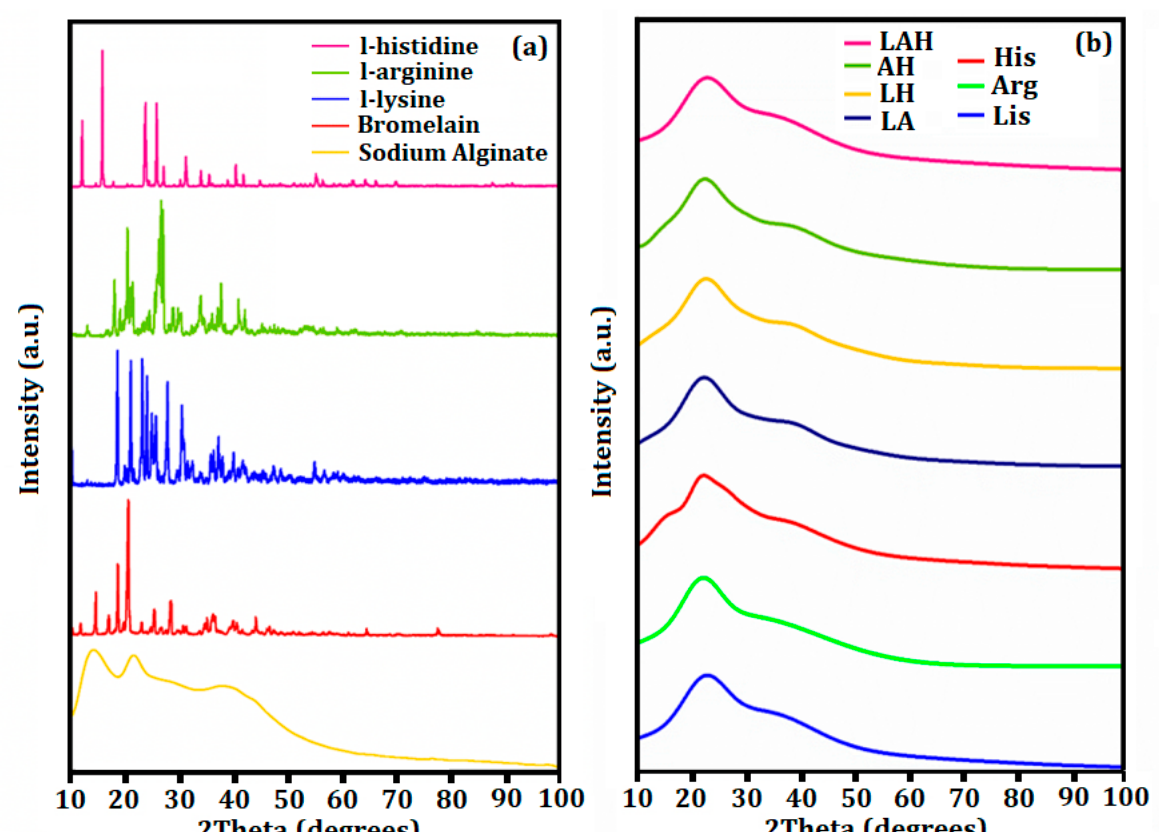
Figure 6. ( a ) XRD patterns of the individual compounds of the developed systems; ( b ) XRD patterns Figure 6. (a) XRD patterns of the individual compounds of the developed systems; (b) XRD patterns of the developed systems. of the developed Developed systems for controlled release of bromelain in the intestines was report- ed by applying Eudragit L100 [65]. The authors found amorphous characteristics con- firmed by XRD analysis, showing the importance of the amorphous property for lower water absorption capacity. The use of carbohydrates in protein microencapsulation has been extensively reported, as well as the use of amino acids to increase the stabilization of tertiary and quaternary structures of proteins [21,29,31,57,72]. Thus, our results indi- cated the potential of combining these materials to preserve the physical and chemical properties of proteins, especially bromelain. 3.8. Morphological Analysis Figure 7 presents the SEM images of the developed systems. Two different mor- phologies were observed, indicating complex drying processes: particles presented smooth or rough shapes. The encapsulation process using amino acids can result in different particle mor- phology [52,56,73]. The roughness shapes can influence the increase of the diffusion rate of the encapsulated systems due to the increase of surface area when compared to uni- formly spherical particles [74–76]. Previous studies have shown that spray drying processes are influenced by tem- perature, viscosity, concentration, and spray nozzle size. As a result, different types of morphology have been obtained. In addition, materials used in microencapsulation can generate rounded, rough structures or structures with holes and halos that indicate pos-